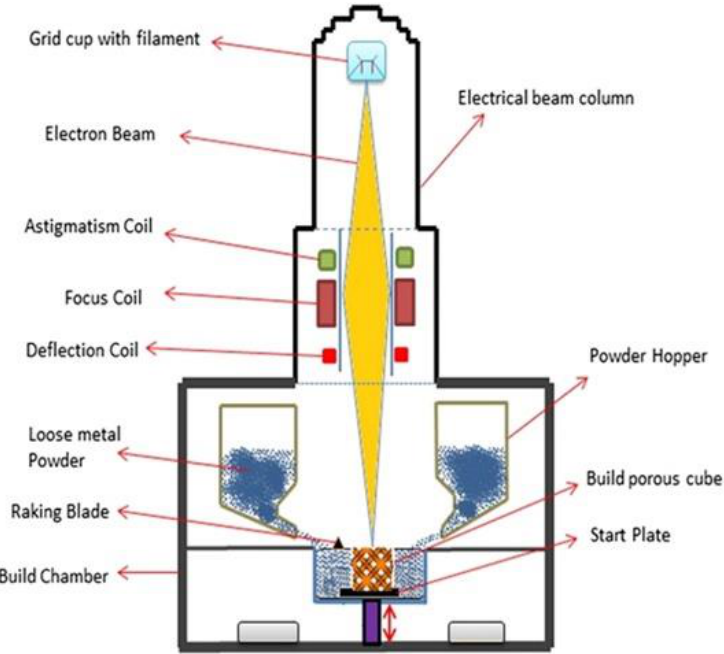
Figure 9. Schematic representation of the electron beam powder bed fusion technique [153].